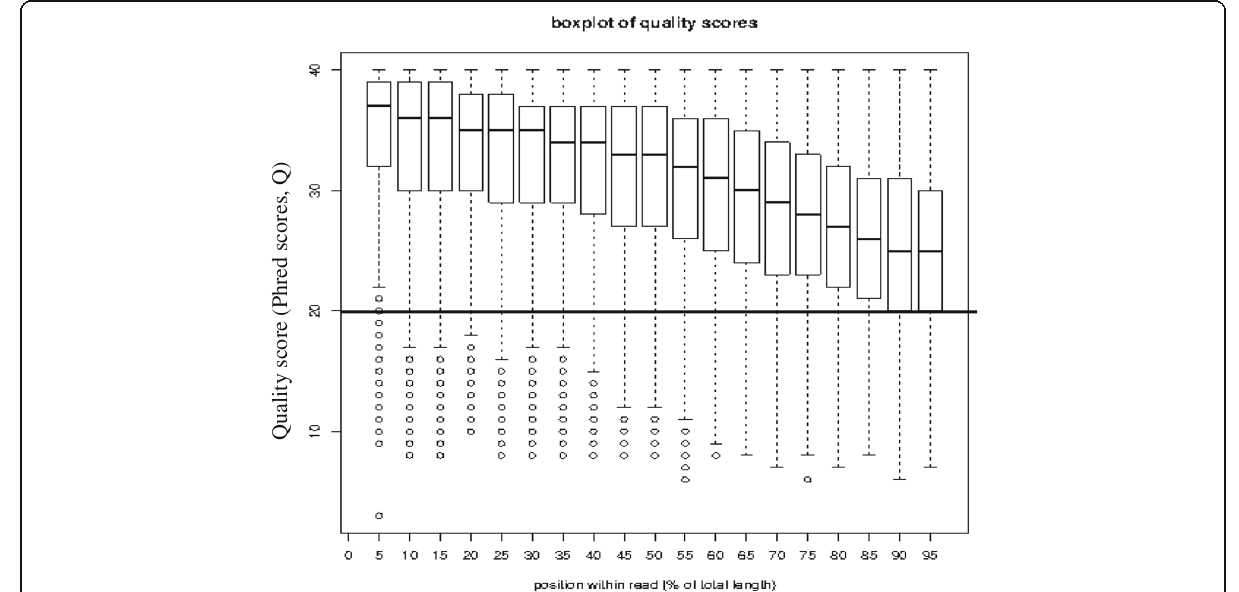
Fig. 9 Box plot showing quality scores of trimmed